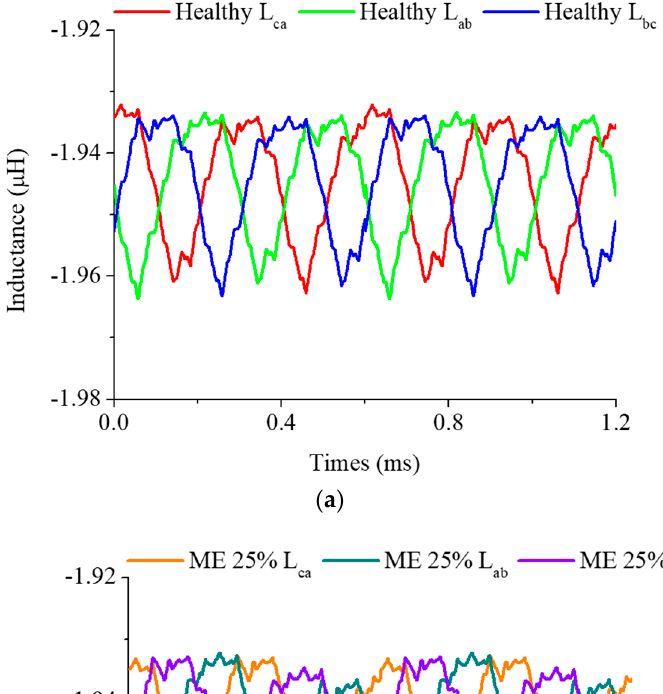
Figure 5. Electromagnetic pressure in the radial direction according to the amount of eccentricity: ( a ) Eccentricity 25% and ( b ) Eccentricity 50%.